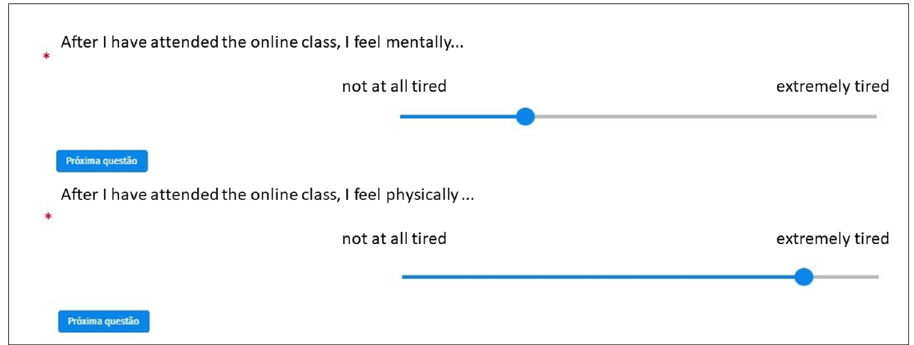
Figure 5. Caption from VAS slider bars (VAS_mental and VAS_physical). The points selected on the slider bars are random.